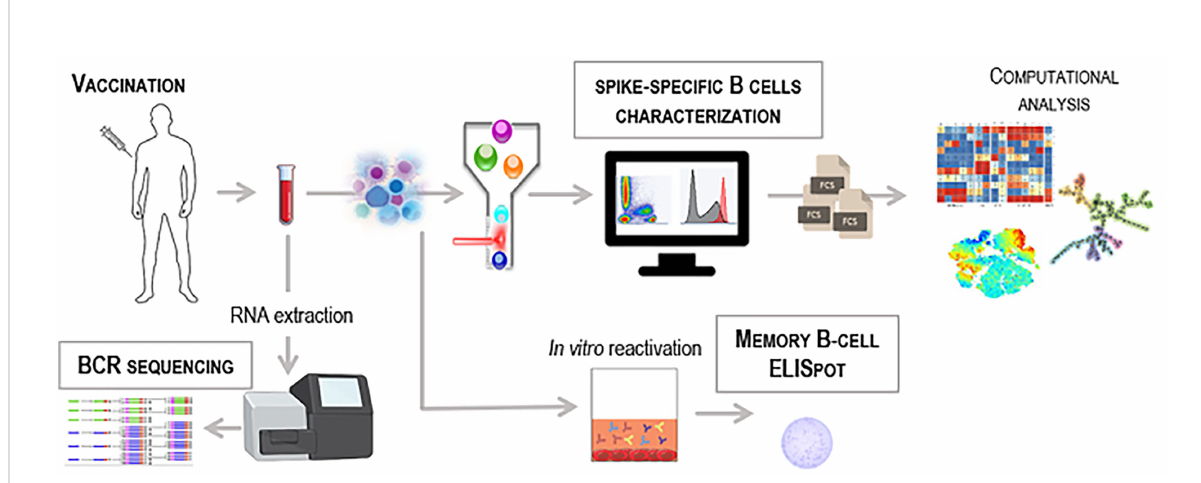
FIGURE 1 Work fl ow for the identi fi cation of vaccine-induced spike-speci fi c B cells. Schematic representation of different technologies to detect antigen- speci fi c B cells in blood samples collected from SARS-CoV-2 vaccinated subjects. PBMC can be used for multiparametric fl ow cytometry analysis labelling cells with the fl uorescent antigen as probe to identify rare antigen-speci fi c B cells. Computational fl ow cytometry can be then applied to explore and visualize multiparametric fl ow cytometry data (fcs fi les) using speci fi c tools and algorithms. Effector function of spike- speci fi c memory B cells can be measured in PBMC by B-cell ELISpot technique upon in vitro restimulation of cells. High-throughput bulk RNA sequencing of BCR heavy-chain genes can be performed on whole blood to unravel the dynamics of the BCR